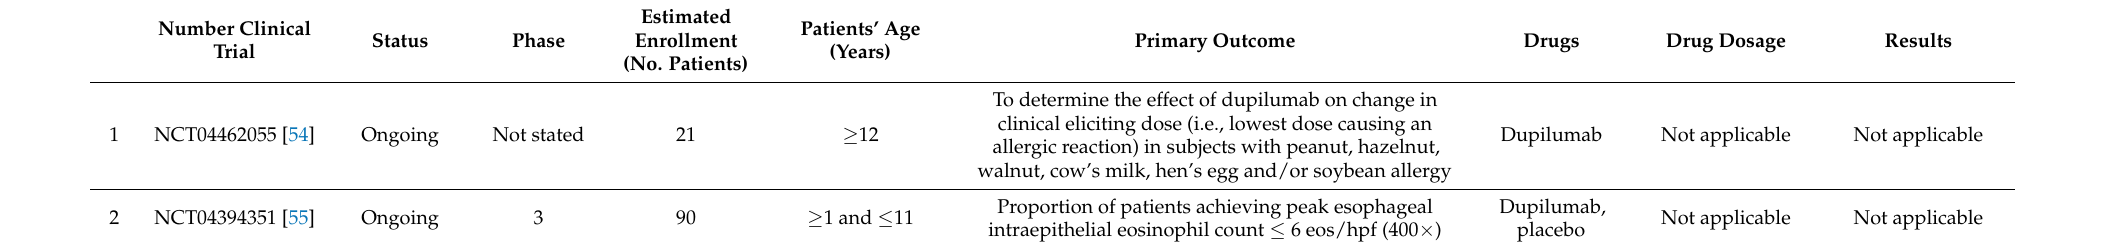
Table 3. Clinical development program for dupilumab as monotherapy or as adjunctive treatment in food